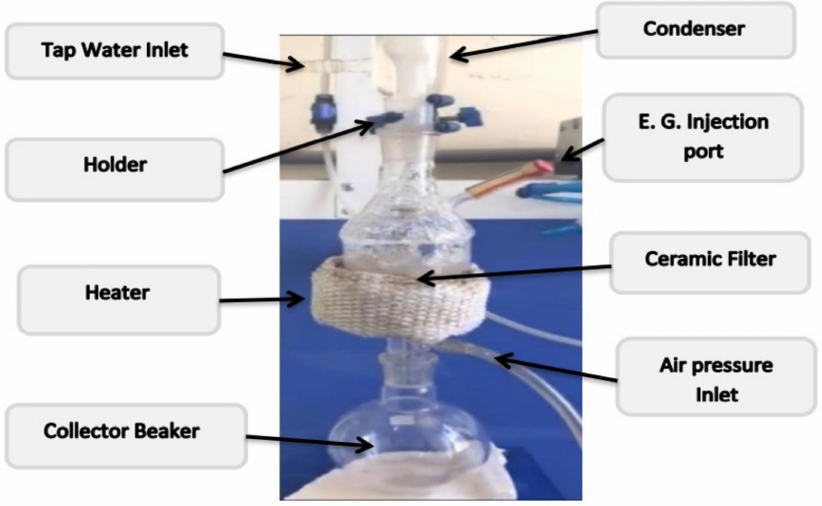
Figure 1. Preparing white crystalline DPET via the bubble column